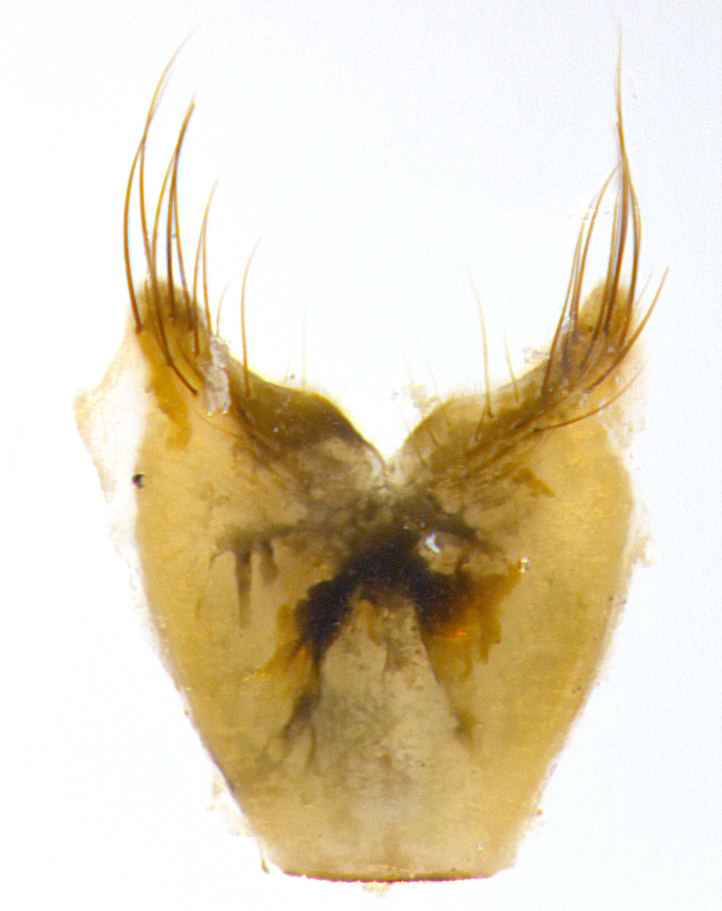
sternite 5, ventral view.